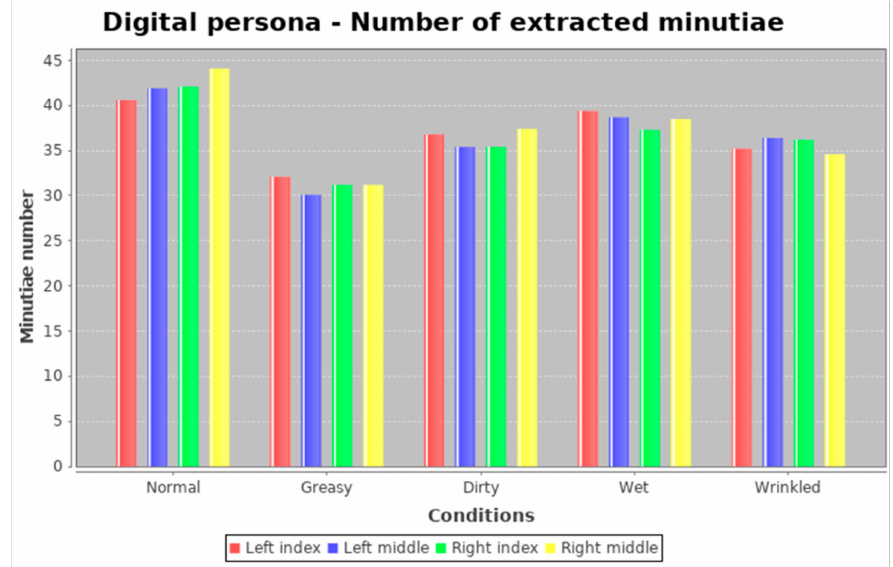
Figure 8. Bar chart displaying the average number of